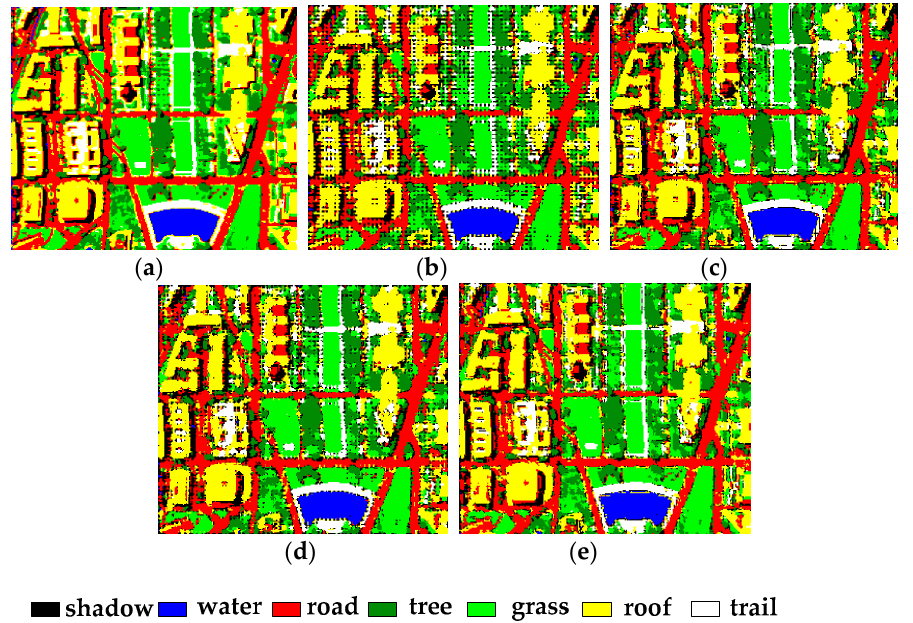
Figure 13. SRMSAM results in Experiment 3 ( S = 4). ( a ) Reference image. ( b ) SPSAM. ( c ) MSPSAM. ( d ) HSAM. ( e ) SRMSAM-PAN.